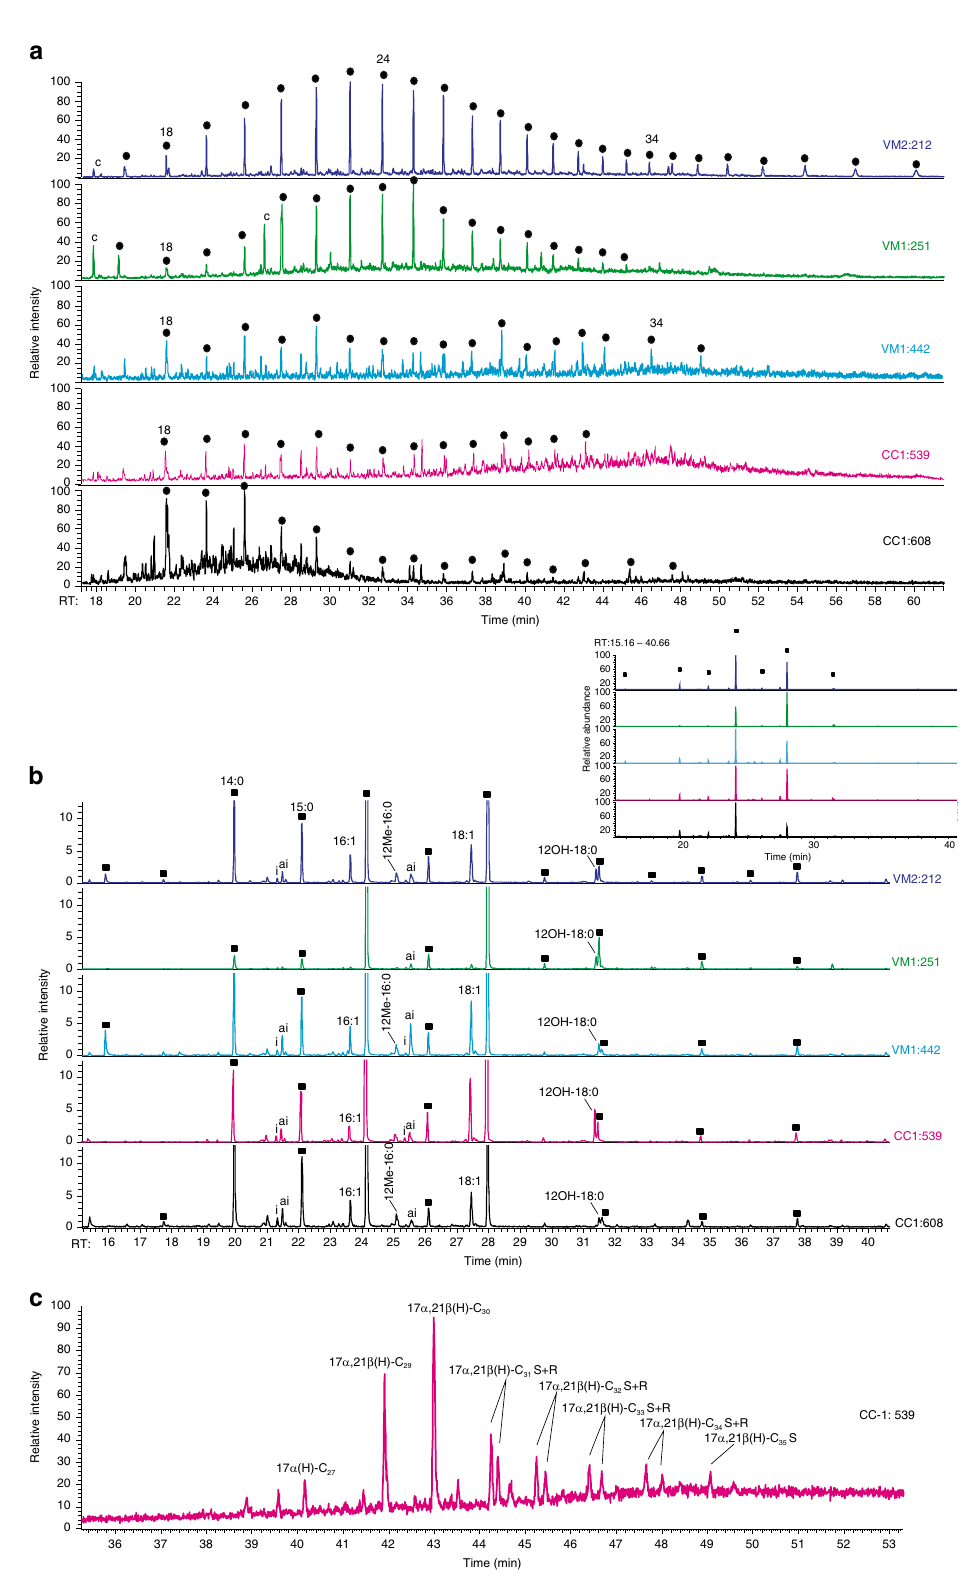
Fig. 6 Partial mass chromatograms. Samples are from limestone fracture (VM2:212), sediment-granite contact (VM1:251) and deep granite fractures (VM1:442, CC1:539, CC1:608), showing ( a ) the n -alkane distribution pattern (straight chain hydrocarbons, m/z 85, ● ), ( b ) the fatty acid distribution (m/z 69, 74; ■ ) of all investigated samples and ( c ) weak hopanoid signals (m/z 191) from the calcite in the granite fracture sample CC1:539